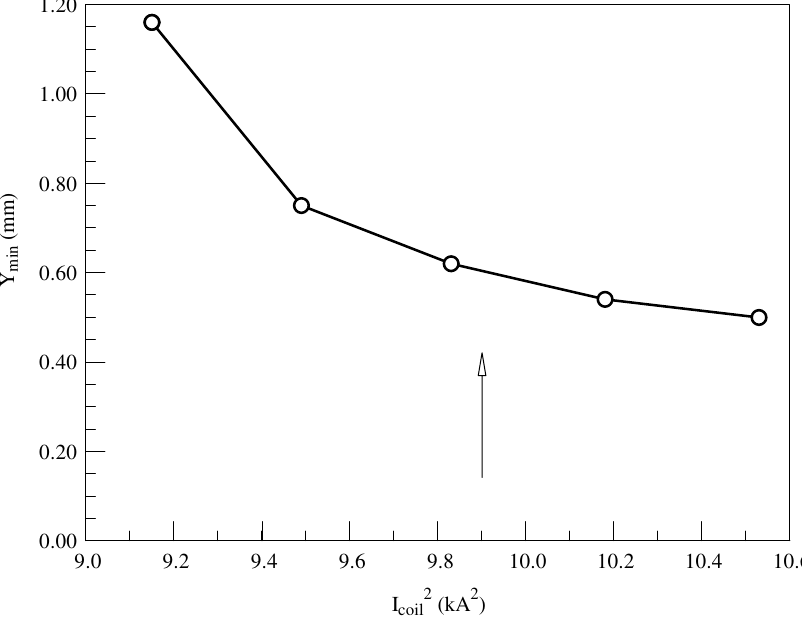
(cid:1) 2 : 200 , R (cid:1) 1 : 818 . Arrow shows the x y